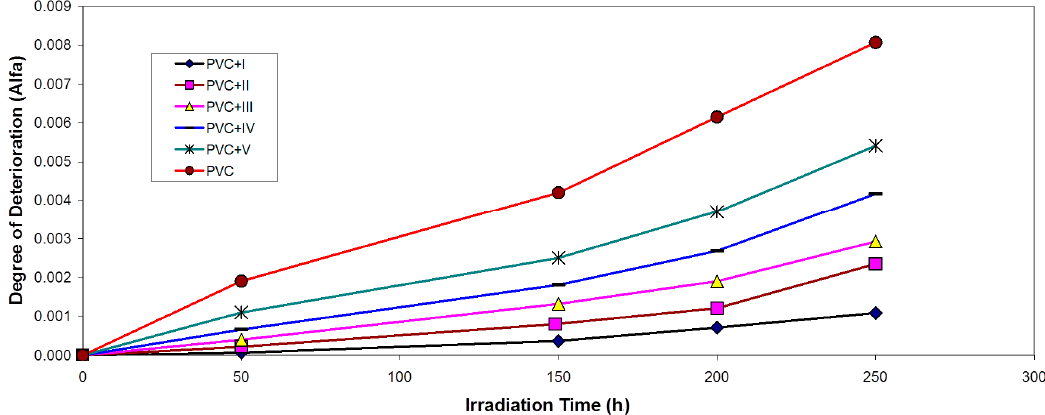
Figure 7. Changes in the degree of deterioration ( α ) during irradiation of PVC films (30 µ m) (control) and with 0.5 wt % of additives.